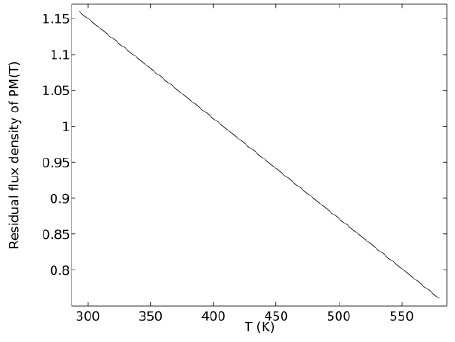
Figure 4. The PM residual flux density curve changes with temperature.